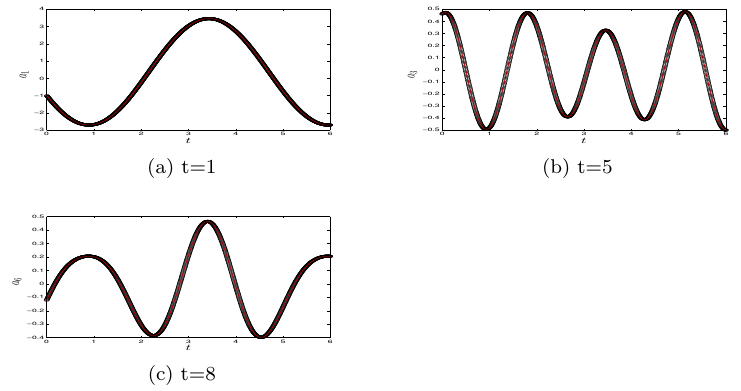
Figure 6. Comparison between the temporal evolutions of the projected (POD) and predicted (POD ROM) mode amplitudes. The POD ROM is calibrated by minimizing J α , with the determination of all the coefficients (constant, linear and quadratic). The regularization parameter α is determined at the inflection point of the